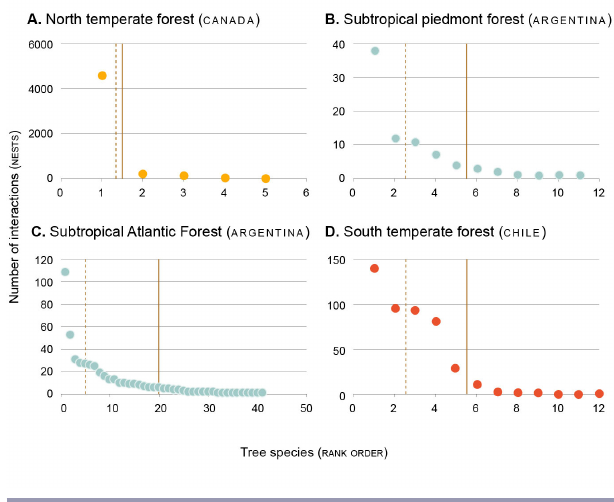
Fig. 4 . Across multiple nest webs, interactions are disproportionately distributed, with < 20% of tree species accounting for > 50% of nests (dashed vertical line), and < 50% of tree species accounting for > 90% of nests (solid vertical line). Data sources: Ruggera et al. (2016); T. A. Altamirano and J. T. Ibarra ( unpublished data ), K. L. Cockle ( unpublished data ), K. Martin ( unpublished data